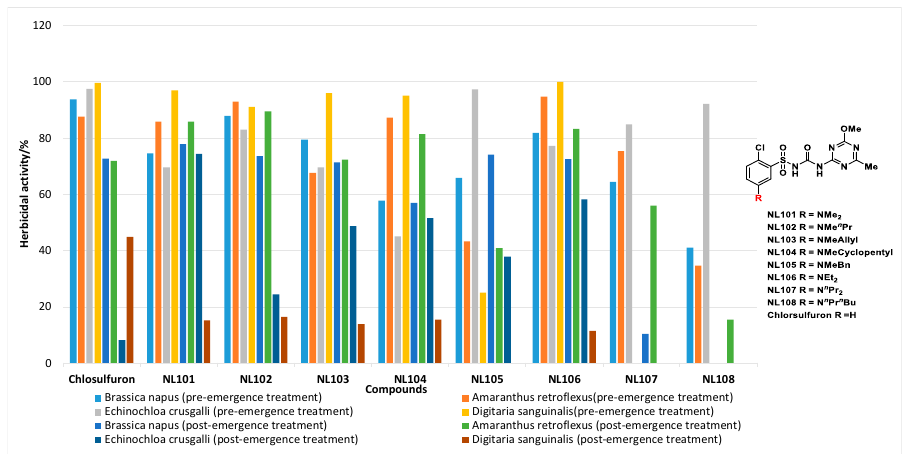
Figure 1. The herbicidal activity of 5-dialkylamino-substituted compounds against both dicotyledons and monocotyledons at 15 g · ha − 1 . (The full data can be found in Table S1).